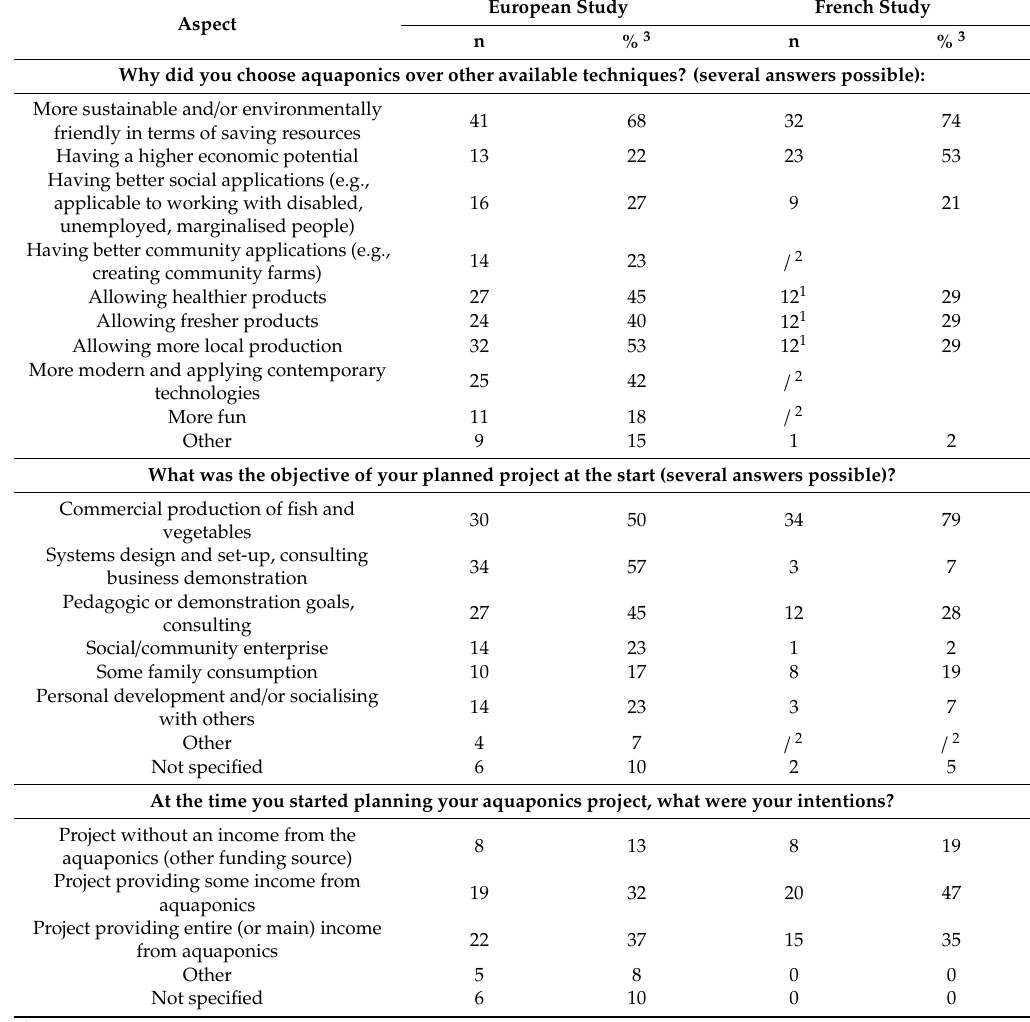
Table 3. Rationale, initial objectives, and initial drivers for aquaponics activity. European Study French Study Aspect n % 3 n %